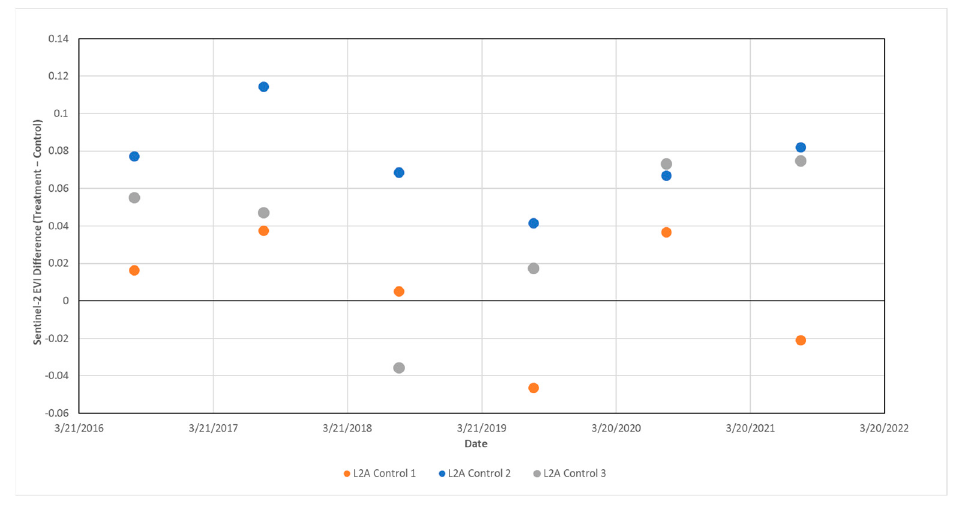
Figure 10. Sentinel-2 mean EVI difference (Treatment–Control, dimensionless) values for the month of August (dry season, when changes in water availability would be most apparent).